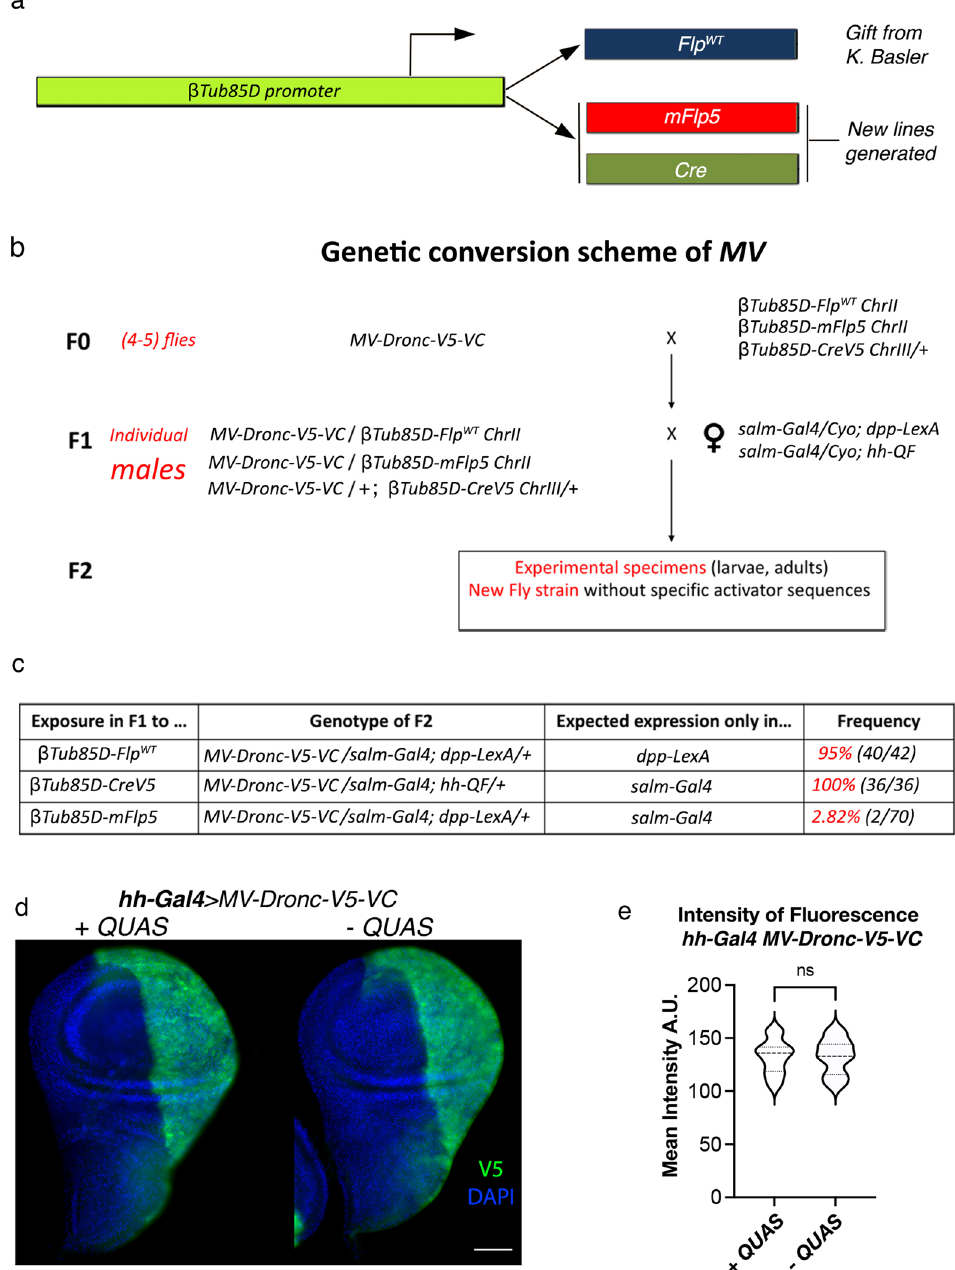
Figure 3. Genetic strategies to permanently eliminate specific activating sequences in the germline. ( a ) Schematic showing the configuration of fly strains previously available ( βTub85D- Flp WT ) or newly generated ( βTub85D-mFlp5 and βTub85D-Cre) to express different recombinases under the regulation of the βTub85D promoter. ( b ) Genetic scheme of intercrosses to permanently eliminate regulatory components of MV constructs in the male germline; this feature can be used to create new transgenic flies containing only a subset of activating binding sites. ( c ) Frequency of germline excision of each gene regulatory element upon exposure to different recombinases. ( d ) Representative of images wing imaginal discs expressing Dronc-V5-VC (anti V5 in green) under the regulation of hh-Gal4 in the posterior compartment using either a fly strain with (+ QUAS ) or without the QUAS (- QUAS ) repeats. DAPI (blue) labels DNA. Scale bar: 50 μm. e) Mean fluorescence intensity (A.U.) of V5 immunostaining in the P compartment of wing discs of the genotypes indicated in d. Statistical significance was determined using an unpaired Student’s t-test; not significant, n.s. number of discs + QUAS n = 20 and – QUAS n = 16; N = 2. Full genotype descriptions of the figure can be found in